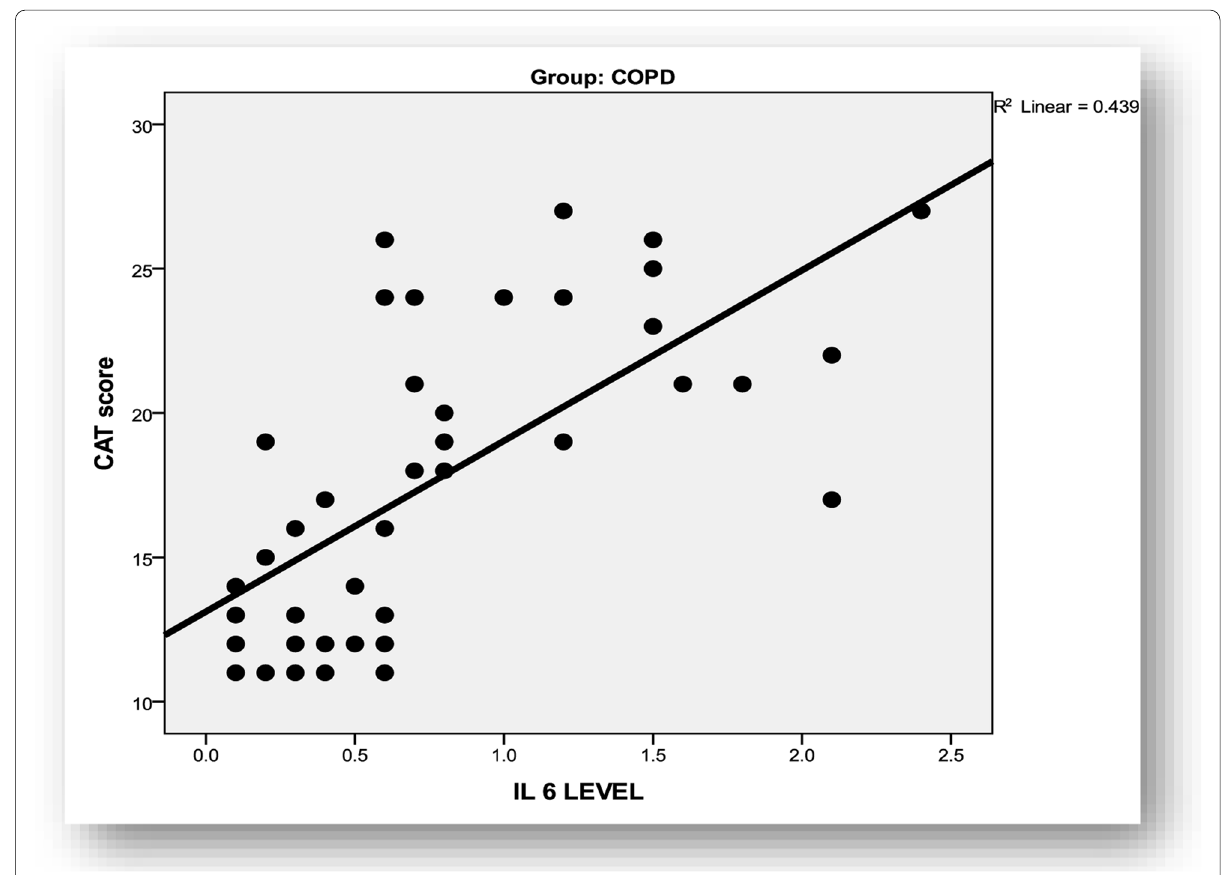
Fig. 4 Correlation between IL‑6 level with CAT score among cases of